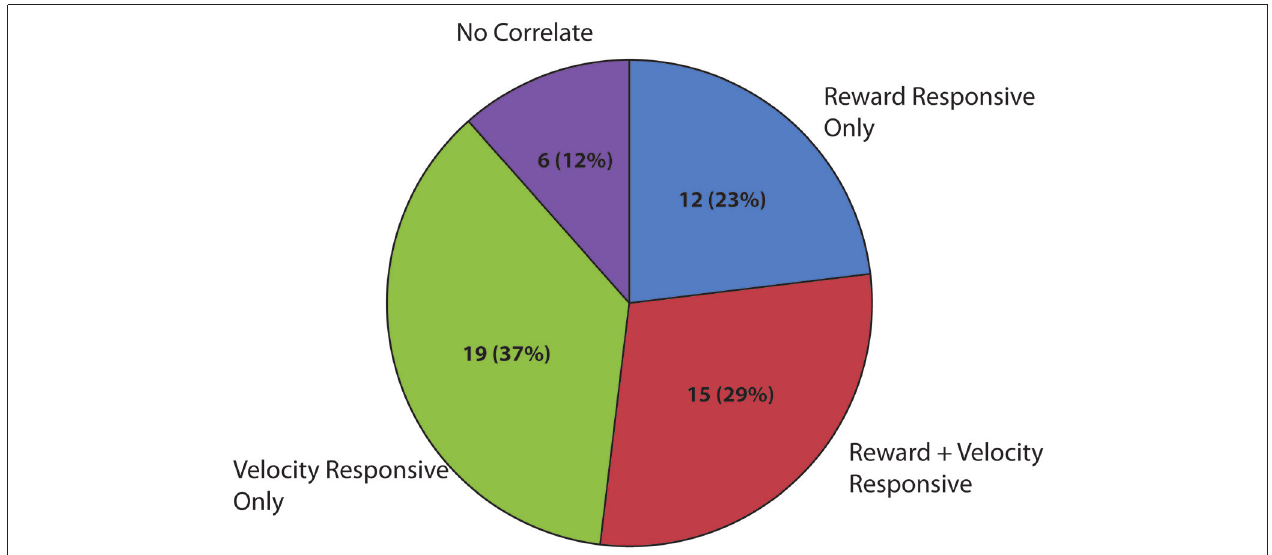
FIGURE 7 | Summary of significantly responding LFP channels during spatial navigation to reward. Numbers represent significantly modulated channels in each category across sessions followed by the percentage of the total number of recorded LFP signals. Velocity responsive channels were defined as a significant correlation (Pearson’s linear) of instantaneous velocity with power in dBs in the theta band (4–8 Hz). Reward related channels were defined as channels which had significantly elevated theta power in the 200 ms surrounding reward arrival as compared with an equal sized time bin 1800 ms after reward encounter when similar velocities and positions were